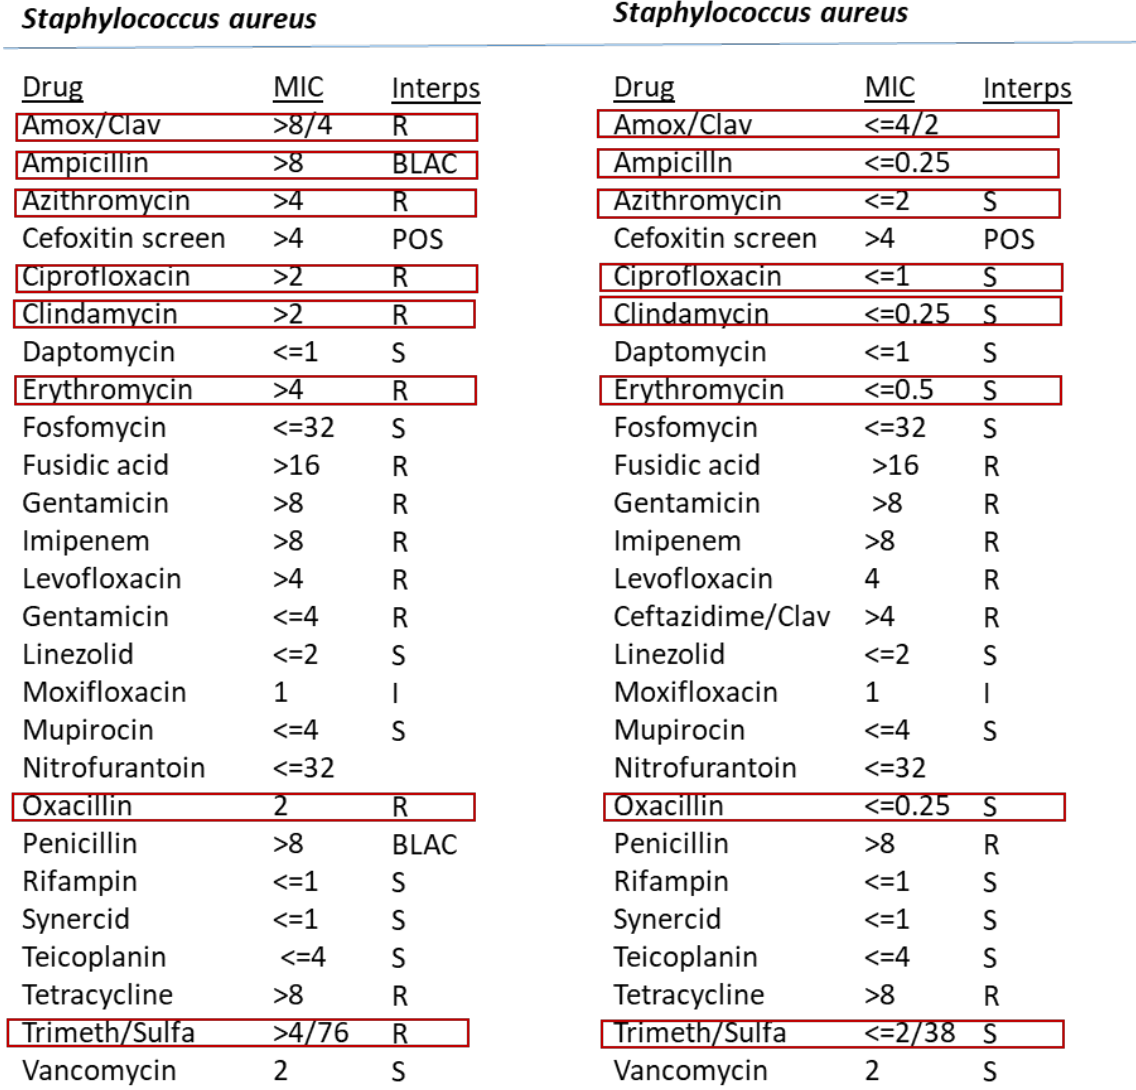
Figure 8. Demonstration of effect of bovine lactoferrin (bLF) on Methicillin resistant Staphylococcus aureus